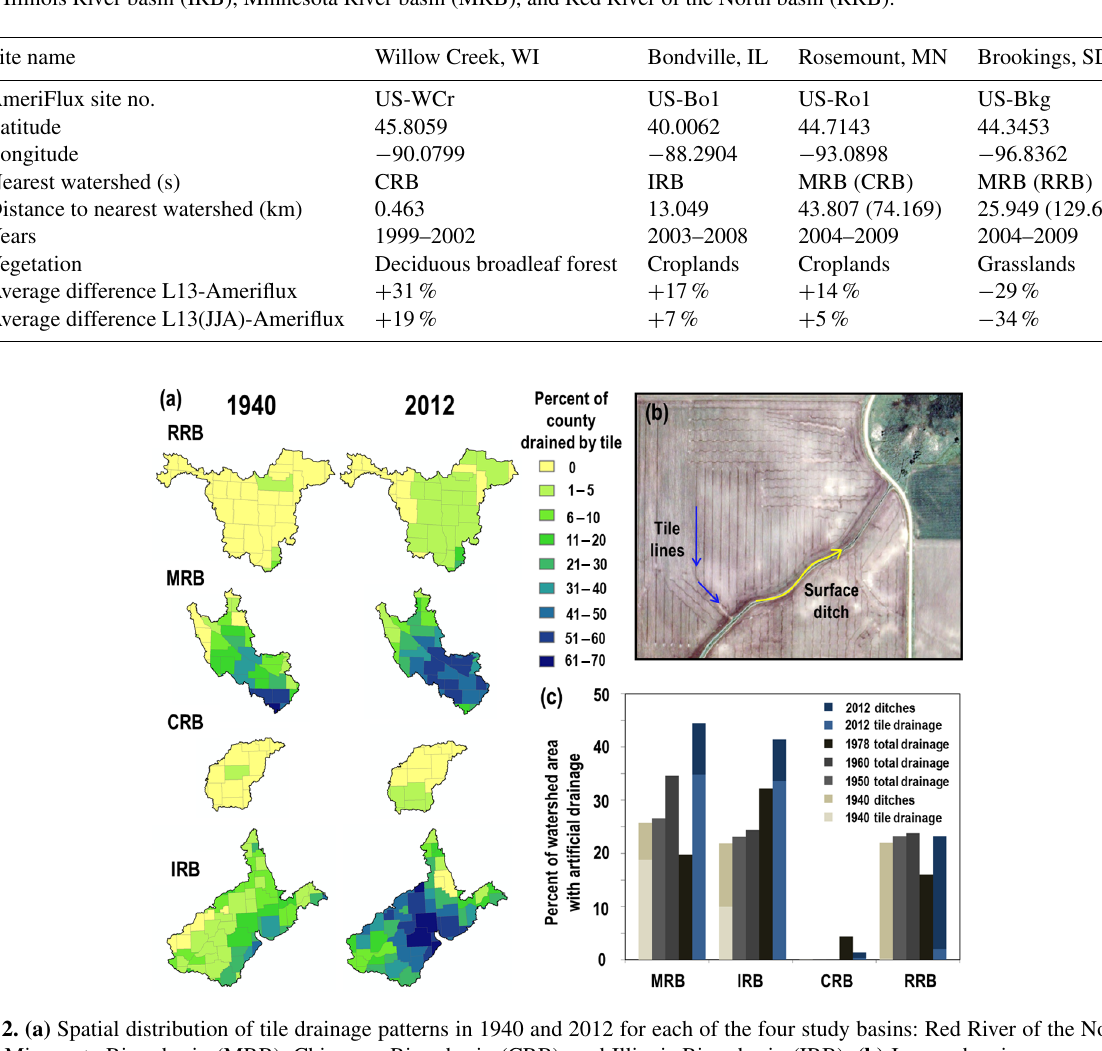
Table 2. Site details for AmeriFlux sites used for comparison with Livneh et al. (2013) evapotranspiration data (L13), where L13(JJA) represents a 17% reduction in ET during the summer months June, July, and August. The average annual difference is positive when L13/L13(JJA) ET is greater than Ameriflux ET and negative when less. The nearest study watersheds are abbreviated: Chippewa River basin (CRB), Illinois River basin (IRB), Minnesota River basin (MRB), and Red River of the North basin (RRB).